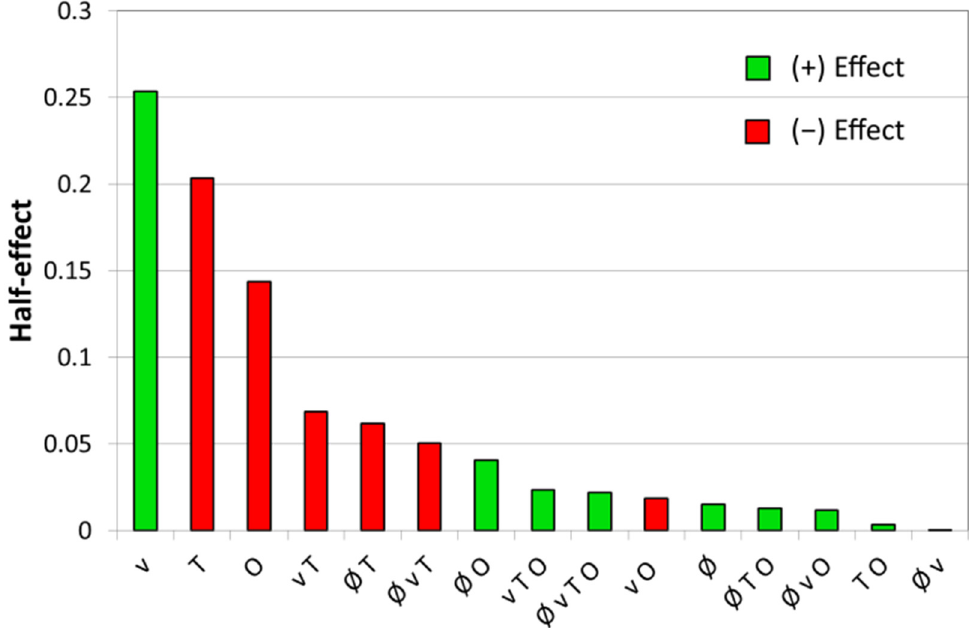
Figure 5. Bar charts showing the half-effects of the parameters and interactions in decreasing order. A positive effect means an increase in the parameter leads to an increase in the roughness, a negative effect does the opposite.